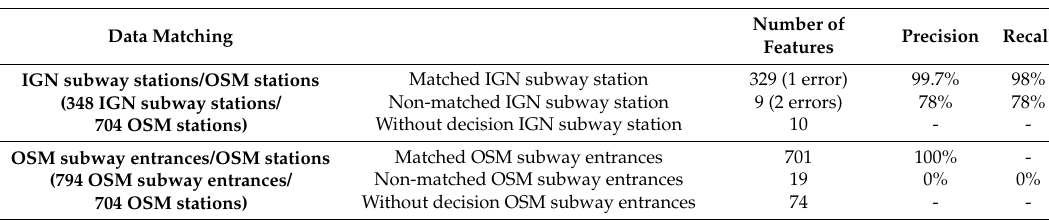
Table 8. Data matching results and evaluation.